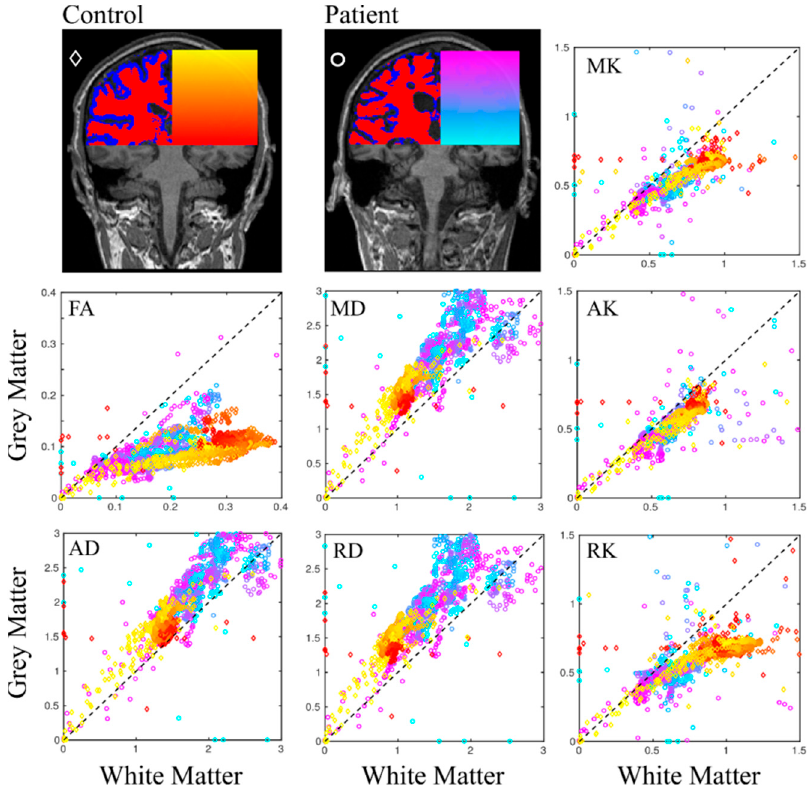
Figure 3. Scatter plots of estimated diffusion metrics for grey/white matter between control/patient groups. Points on the scatter plot are encoded by the colour in respect to the axial slice position and control/patient groups. All diffusion metrics were aligned to T1-weighted individual images. Diffusion units for mean, axial, and radial diffusivities (MD, AD, and RD) are in ( μ m 2 /ms). The dashed line presents the linear dependence. Table 2. Control (C) versus patients (P) groups comparison of mean/standard deviation diffusion scalar metrics.